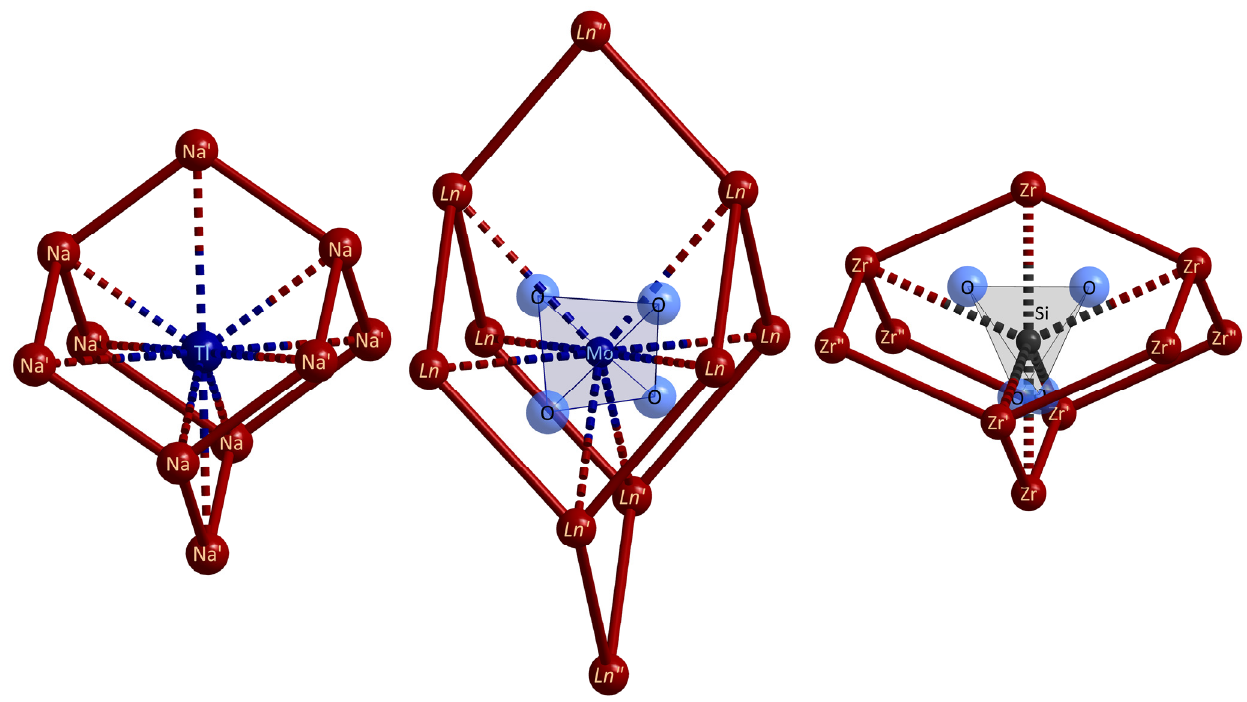
Figure 3. Adamantane -like cages of Na + around Tl – in NaTl ( left ), of Ln 3+ around [MoO ] 2– in the scheelite structure ( middle ), and of Zr 4+ around [SiO 4 structure ( right ).